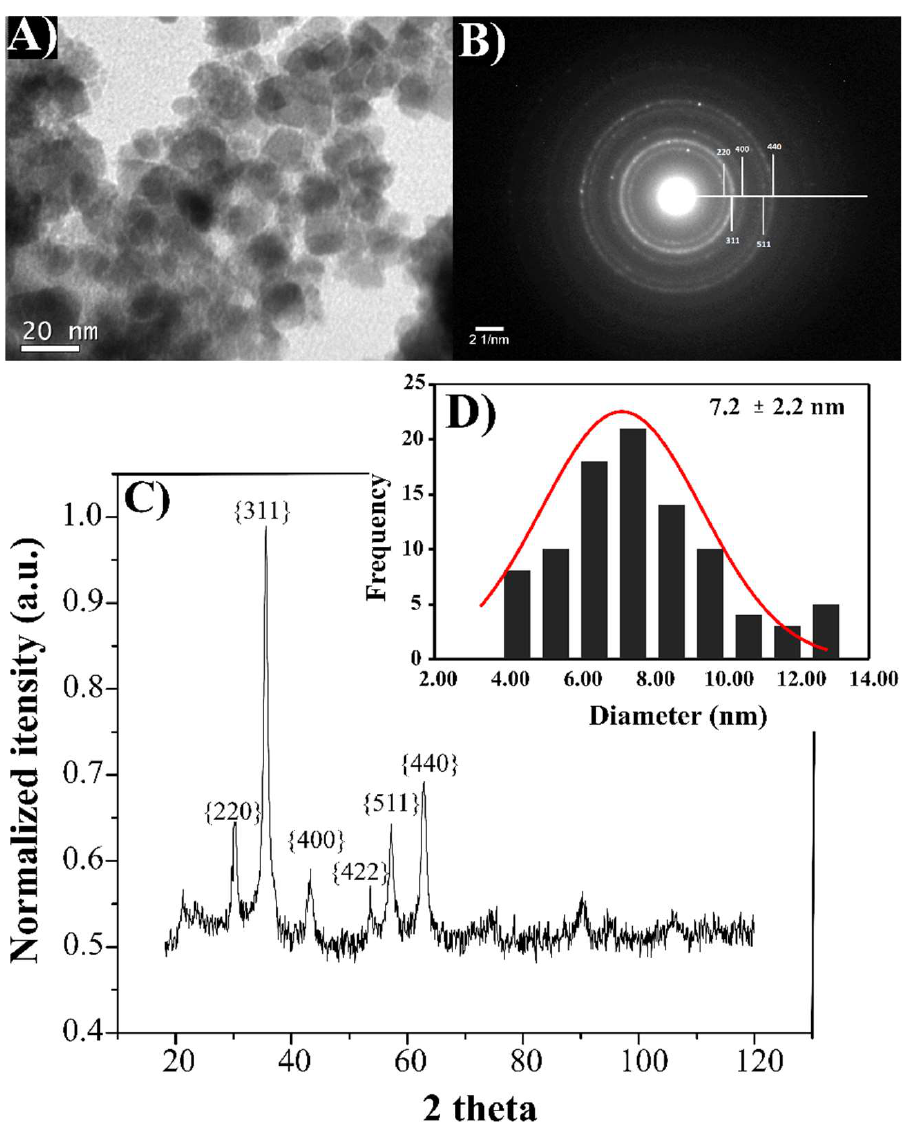
Figure 2. SPION@PGlCLCys ( A ) Low magnification TEM image; ( B ) SAED; ( C ) XRPD diffractogram with diffraction peaks indexed to the spinel iron oxide phase. ( D ) Particle size distribution of the magnetic nanoparticles obtained from the TEM